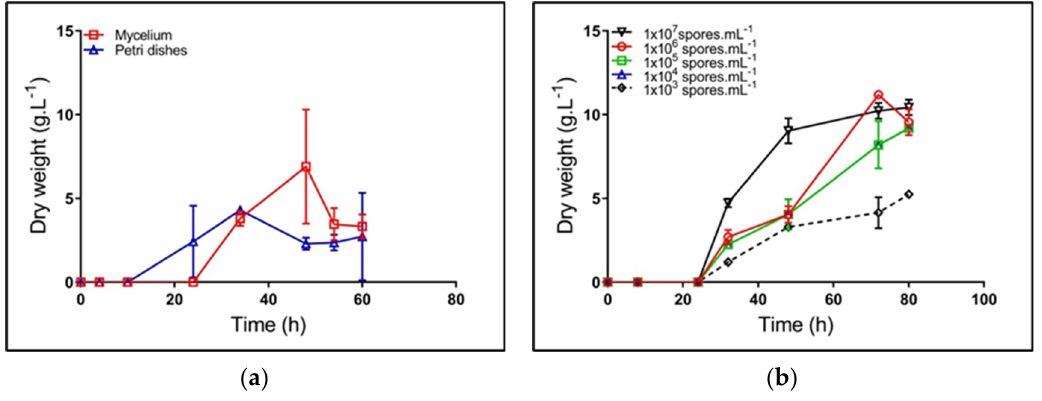
Figure 2. Kinetics of biomass synthesis of Streptomyces clavuligerus grown in a Trypticase soy broth (TSB) medium, using different inoculum sources: ( a ) mycelium (square) and petri dishes (triangle); ( b ) spore suspensions at concentrations between 1 × 10 3 and 1 × 10 7 spores/mL. Table 2. Kinetic parameters for S treptomyces clavuligerus cultivation according to different inoculum sources.